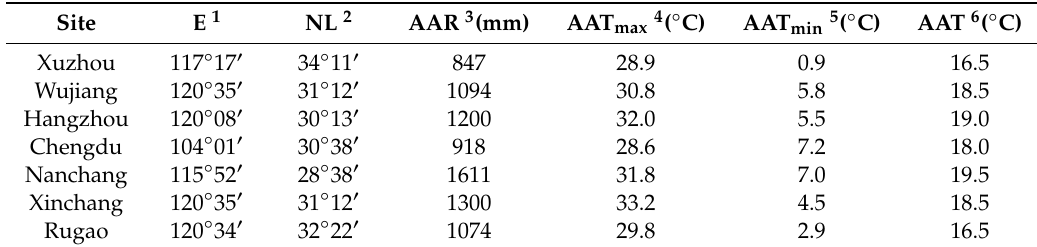
Table 2. The climate characteristics of